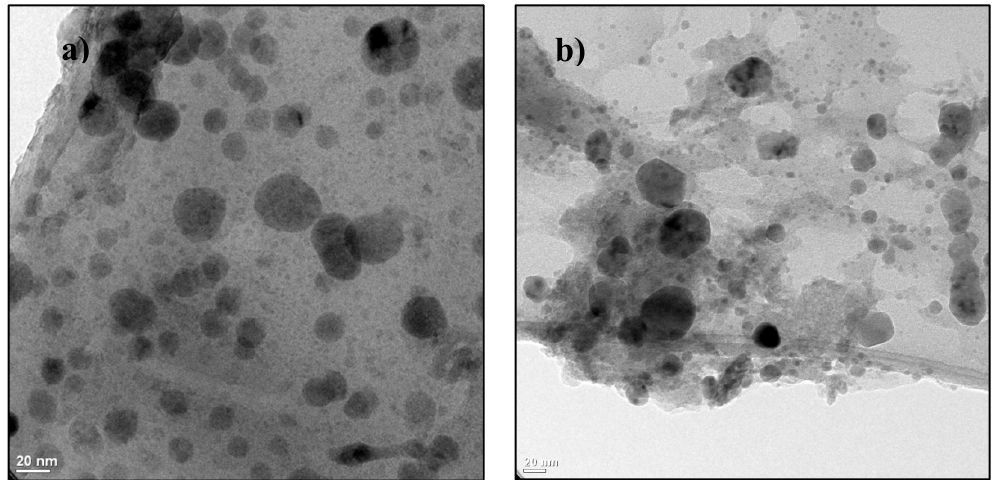
Figure 2. TEM micrography of selenium ( a ) and copper ( b ) nanoparticles.